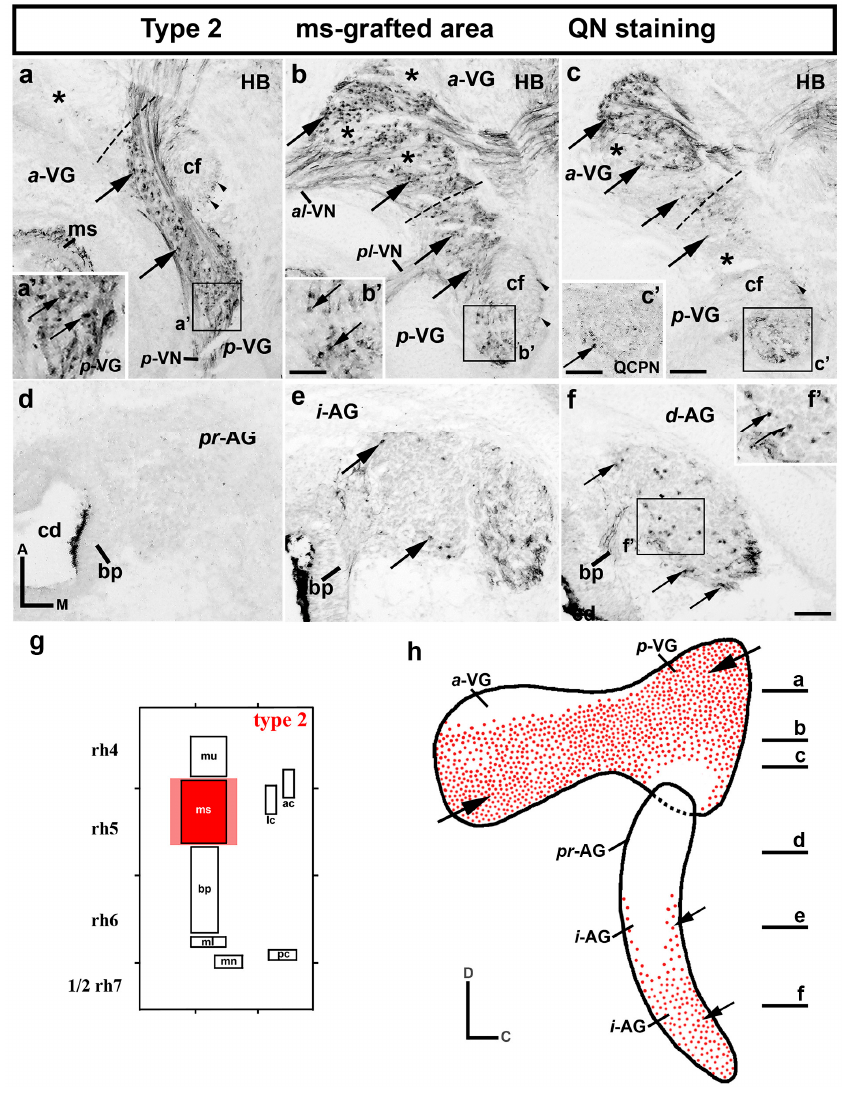
Figure 2. Graft-derived quail ganglionic neurons from the extended area of the macula sacculi (type-2 grafts; n = 9). ( a – f ) serial horizontal sections stained with QN antibodies through the vestibular (VG in ( a – c )) and acoustic (AG in ( d – f )) ganglia. ( a – c ) The dotted lines define the separation between the anterior and posterior lobes of the VG ( a -VG and p -VG). QN-stained grafted quail neurons were detected in areas of the a -VG and p -VG (arrows in ( a – c )), with other areas devoid of ms-grafted neurons (asterisks in ( a – c )). In the AG, the i -AG and d -AG displayed a reduced number of QN-positive neurons (arrows in ( e , f )), with the pr -AG without any QN-positive quail neurons ( pr -AG in ( d )). ( a – c ) The arrowheads point to axons in the cochlear nerve fascicle (cf). ( g ) Schematic representation of type-2 grafts performed at the 10-somite stage, considering the expanded sensory area of the macula sacculi (ms; dark and light red areas). ( h ) Diagram summarizing the results, in which horizontal sections are indicated. The arrows point to the most signi fi cant accumulations of ms-grafted quail neurons. Orientation: A, anterior; C, caudal; D, dorsal; M, Medial. Additional abbreviations: al -VN, anterolateral vestibular nerve; ap -VN, anteroposterior vestibular nerve; bp, basilar papilla; cd, cochlear duct; HB, hindbrain; ms, macula sacculi; p -VN, posterior vestibular nerve; pl -VN, posterolateral vestibular nerve. Scale bar = 11 µm in ( a’ , b’ ); 20 µm in ( a , b , c ); 14 µm in ( c’ ); 12 µm in ( d , e , f ); 8,5 µm in ( f’ ).